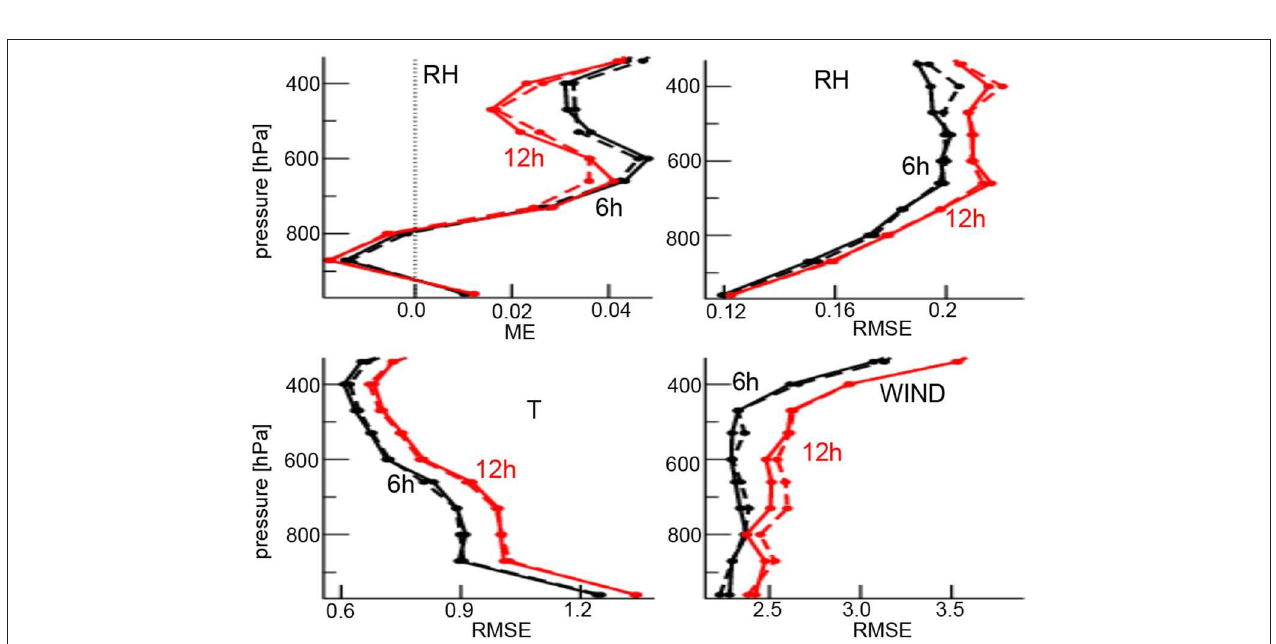
FIGURE 9 | Forecast verification statistics for relative humidity (RH), temperature (T) and wind speed (WIND) vs. radiosonde observations for the summer period 2016 with lead times 6 h (black) and 12 h (red). Results of the experiment NO-SEVIRI are shown by dashed lines and SEVIRI-NEW results by solid lines. The statistic ME is the forecast-observation bias, RMSE is the root-mean square error of forecasts to observations. The forecast statistics are averages over all initial times and considers the same observations to verify both experiments.